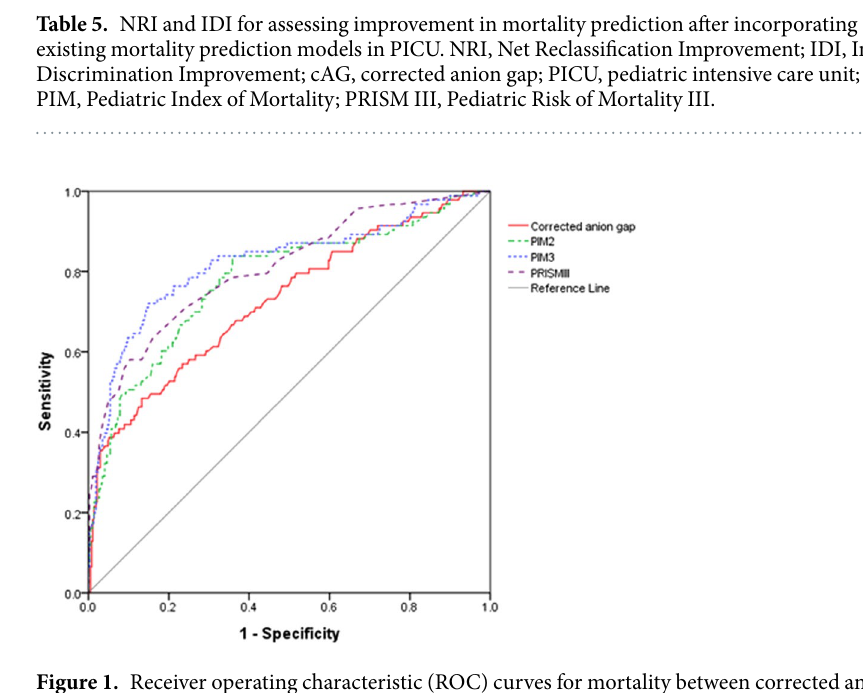
Figure 1. Receiver operating characteristic (ROC) curves for mortality between corrected anion gap and pre- existing mortality prediction models in PICU. There were no differences between corrected anion gap and other prediction models for mortality. PIM3 showed the best power to predict in-hospital mortality (area under the ROC curve, 0.822 [95% CI, 0.767–0.877]).